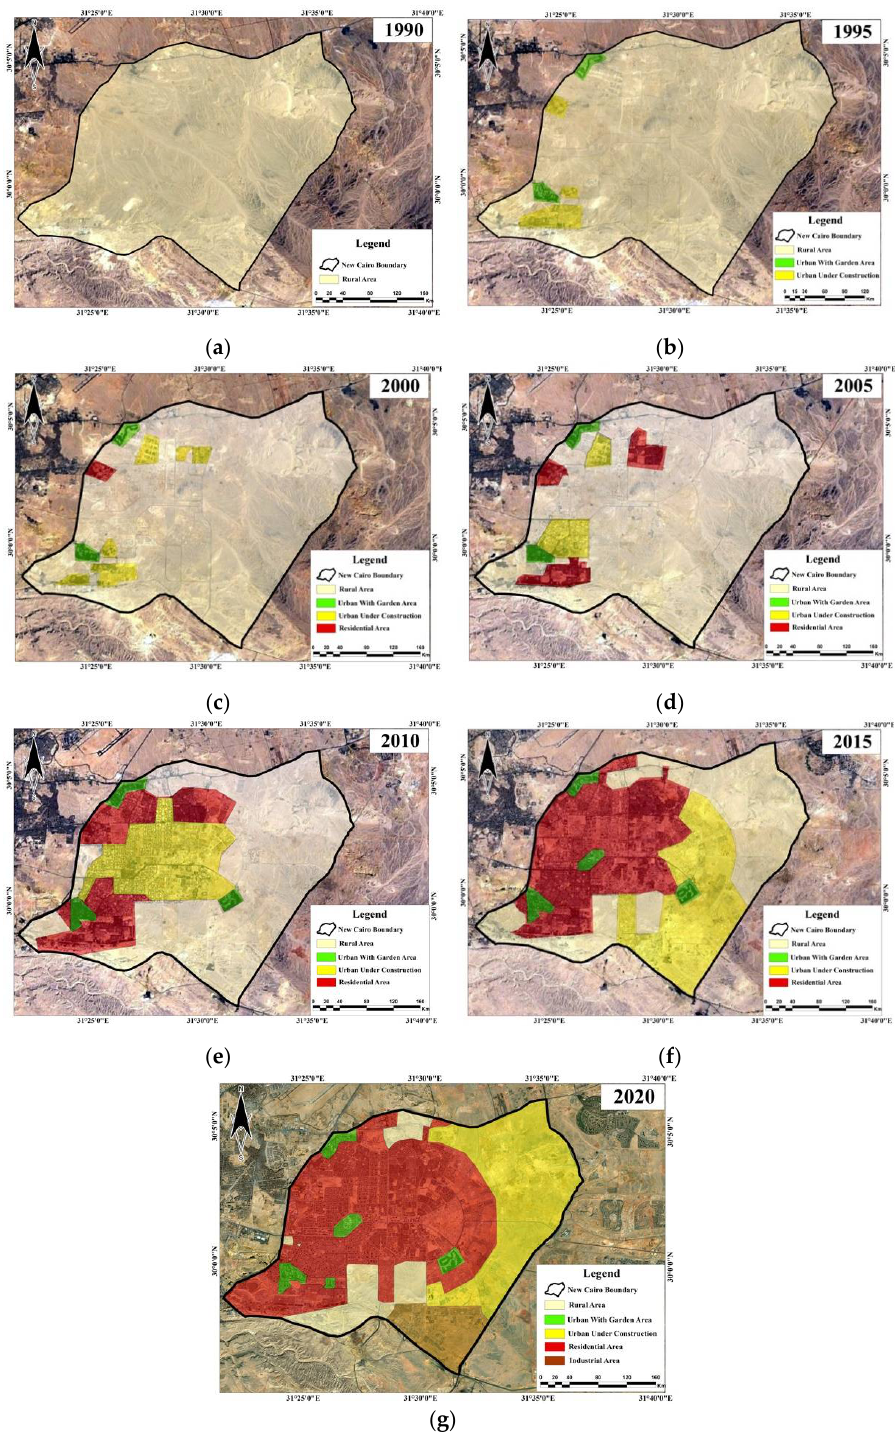
Figure 5. The results of historical land use changes for the years ( a ) 1990; ( b ) 1995; ( c ) 2000; ( d ) 2005; ( e ) 2010; ( f ) 2015; ( g ) 2020. The land use includes rural presented in beige, green areas in green, urban areas in red, and urban under construction in yellow.